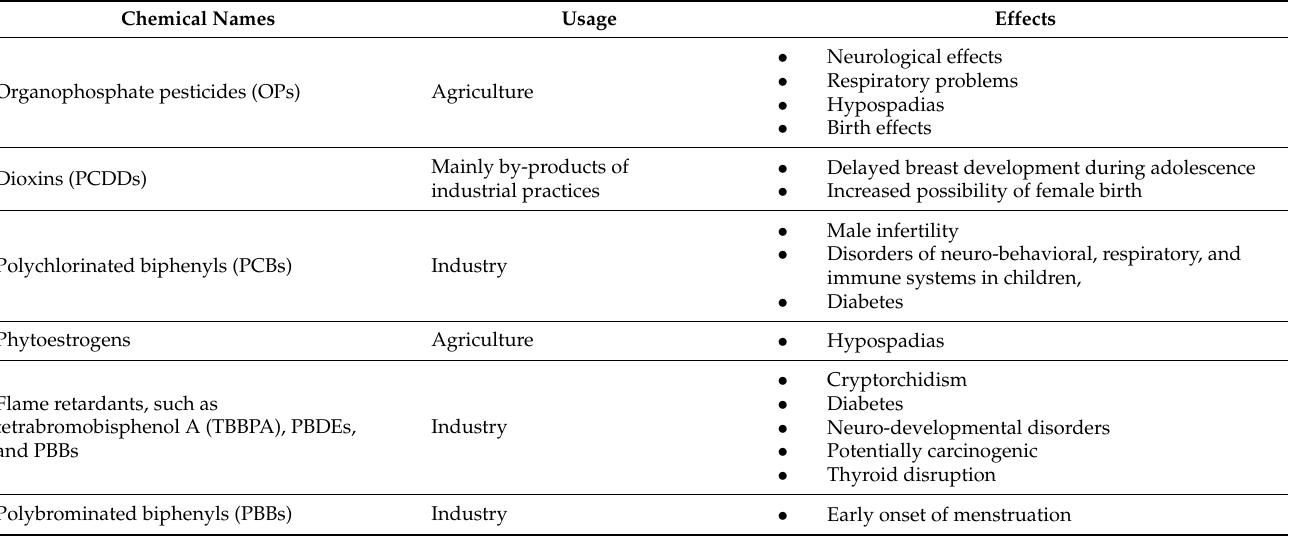
Table 1. Chemical names, usage, and reported effects of specific compounds with potential endocrine action